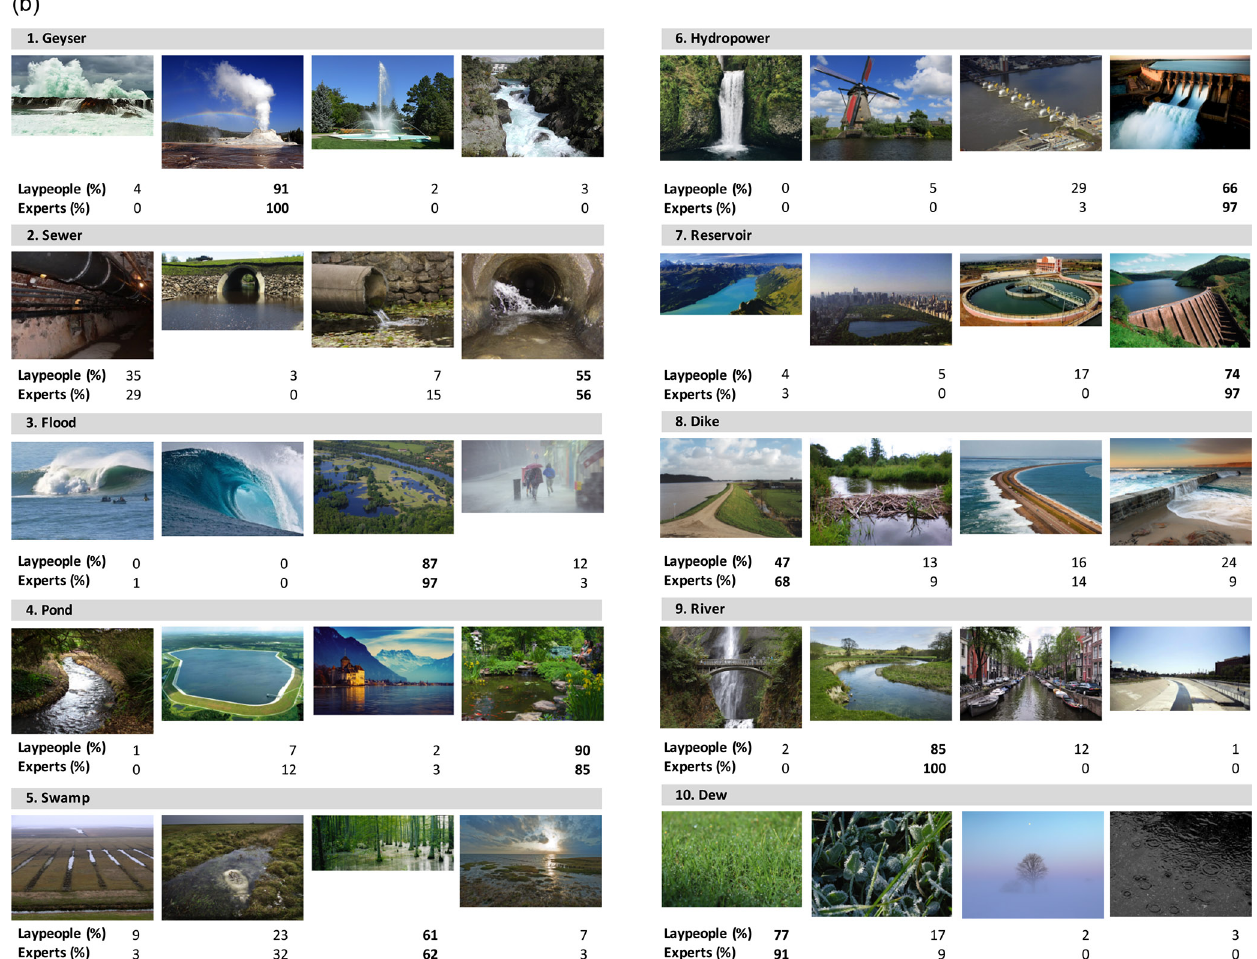
Figure 2. (a) Bar charts showing the answer distribution of both textual and pictorial questions (pictorial questions are marked with an asterisk, ∗ ). (b) Answer distribution of pictorial questions (the number of layperson respondents was 115 to 117: N = 115 for hydropower, reservoir; N = 116 for geyser, pond, swamp, dike, dew; N = 117 for sewer, flood,